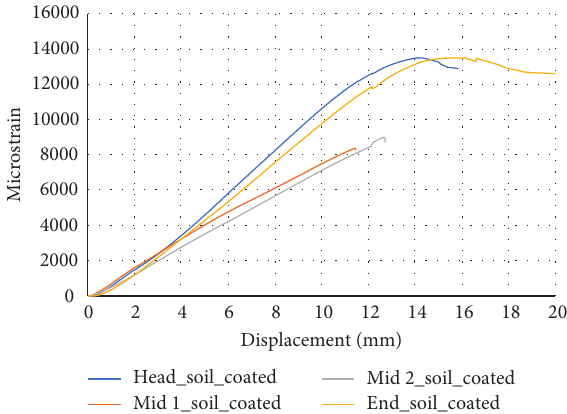
Figure 26: Strain vs. displacement for coated GFRP rock bolt sensor fixed with soil.